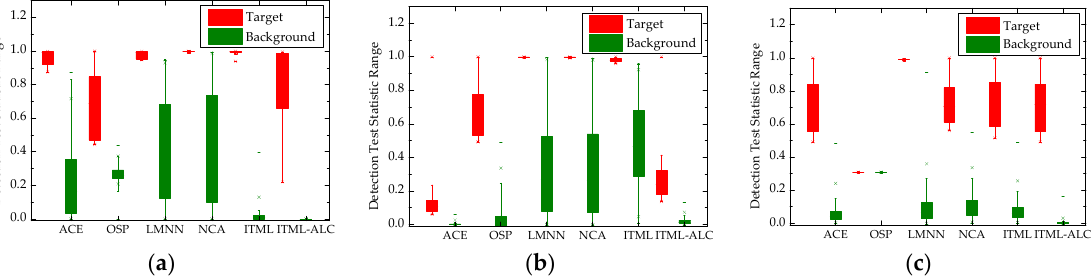
Figure 10. Target-background separation maps of the different algorithms. ( a ) AVIRIS LCVF dataset; ( b ) AVIRIS San Diego airport dataset; ( c ) HYDICE urban dataset.